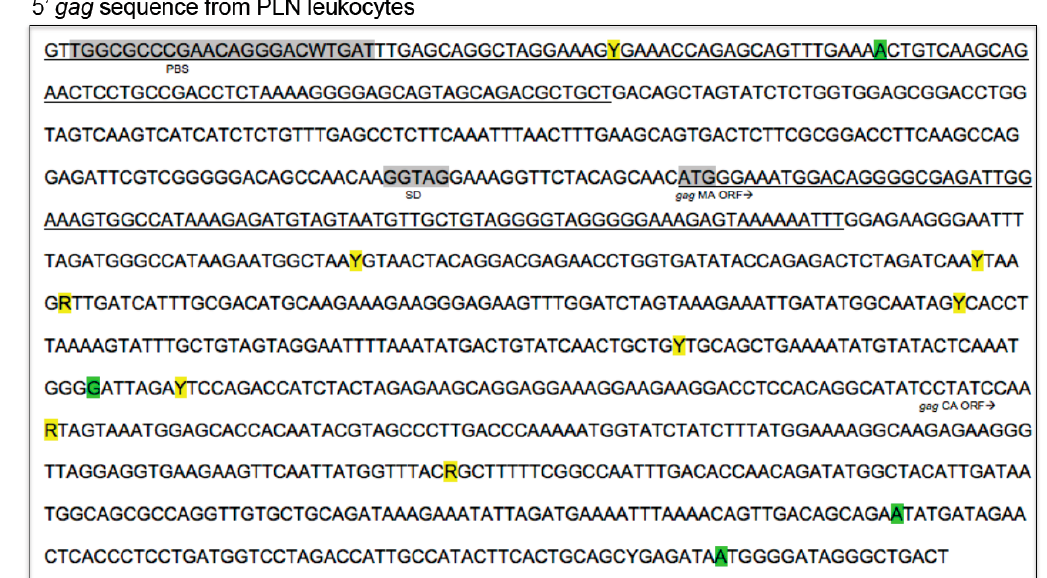
Figure 6. FIV 5’ aspect of the proviral gag consensus sequence derived from PLN leukocytes. The sequence is derived from unfractionated leukocytes from all four FIV-infected cats. Point mutations highlighted in yellow indicate SNPs and green indicates either a deletion or SNP was identified at this locus. “R” denotes nucleotide replacement with a purine base (A or G) and “Y” denotes replacement with a pyrimidine base (T or C). Primer binding site (PBS, grey box) and splice donor (SD, grey box) sites are represented. The start positions of the gag MA and gag CA open reading frames are denoted. Underlined sequences are required for efficient viral packaging [14].